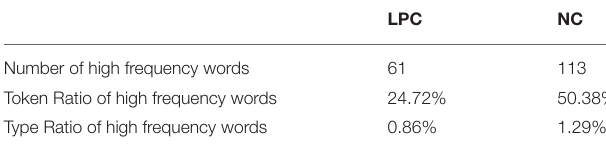
TABLE 8 | High frequency word distribution basic information of LPC and NC.